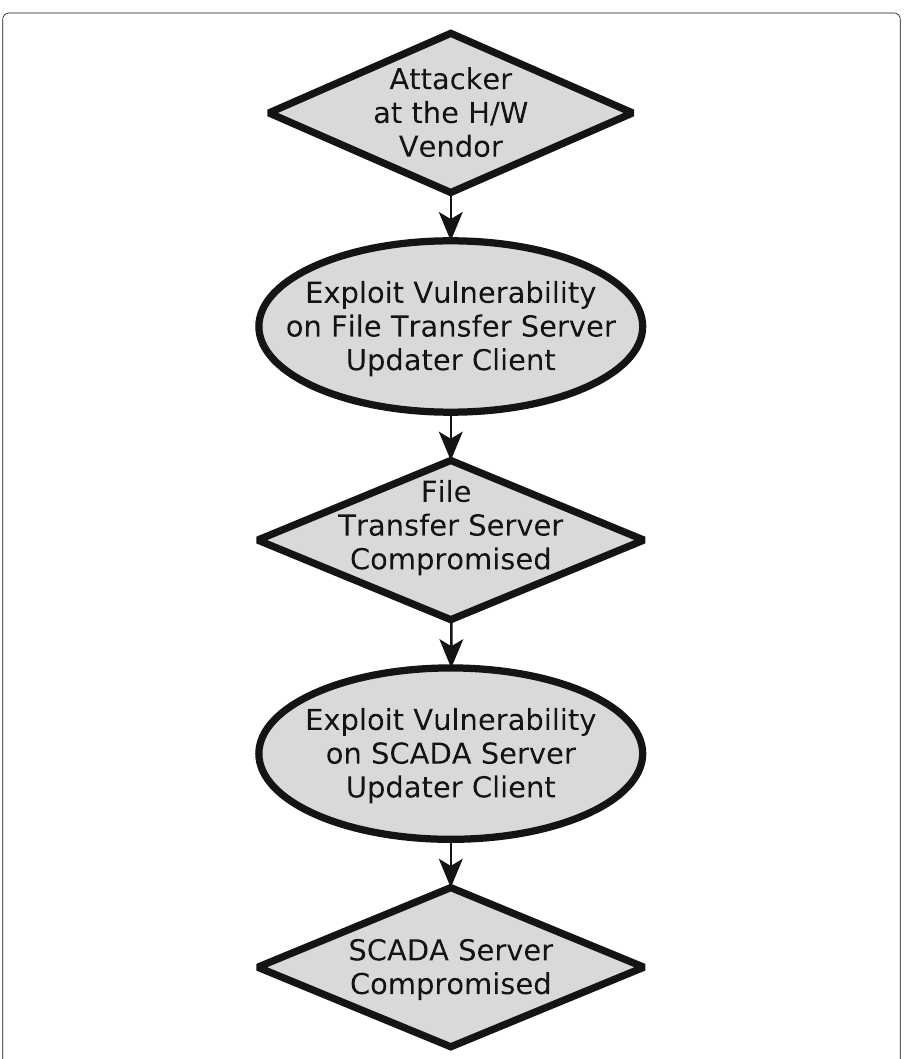
Fig. 8 Aggregated attack graph of an attacker positioned at the software